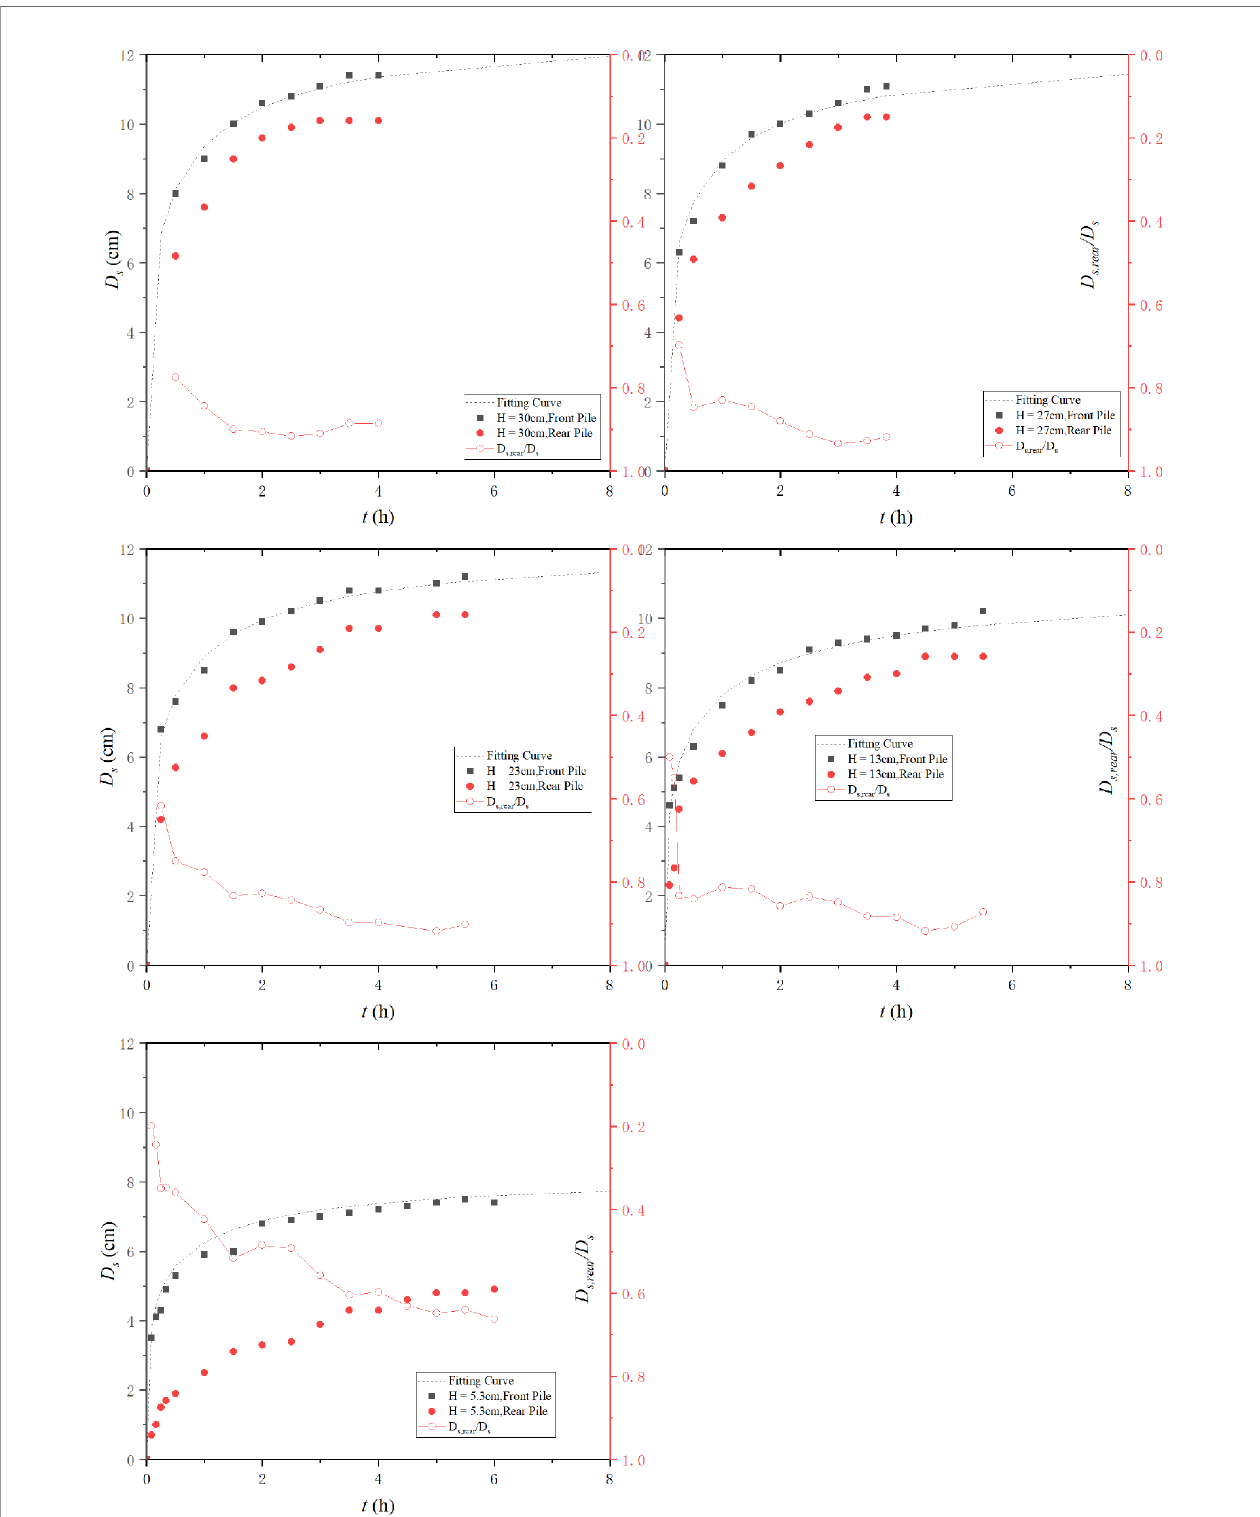
FIGURE 7 | Temporal development of scour depth around front pile and rear pile ( U / U c =